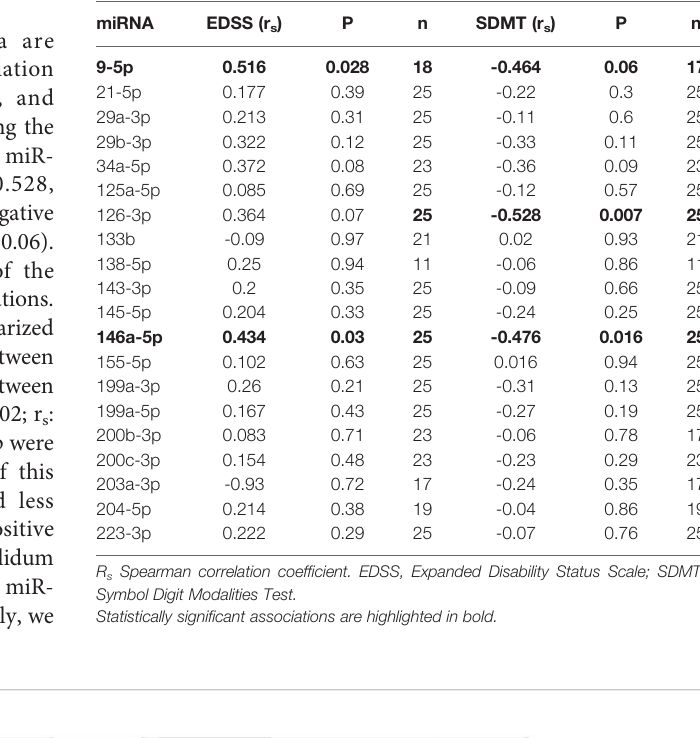
TABLE 4 | Correlations between miRNAs and EDSS and SDMT.